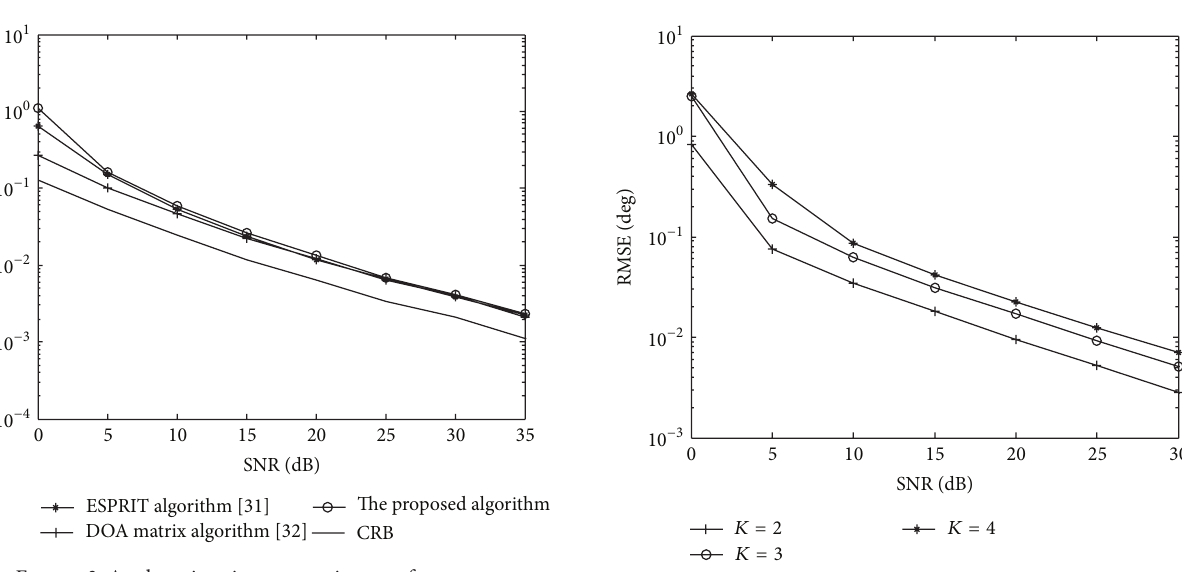
Figure 5: Angle estimation with different values of 𝐾 .